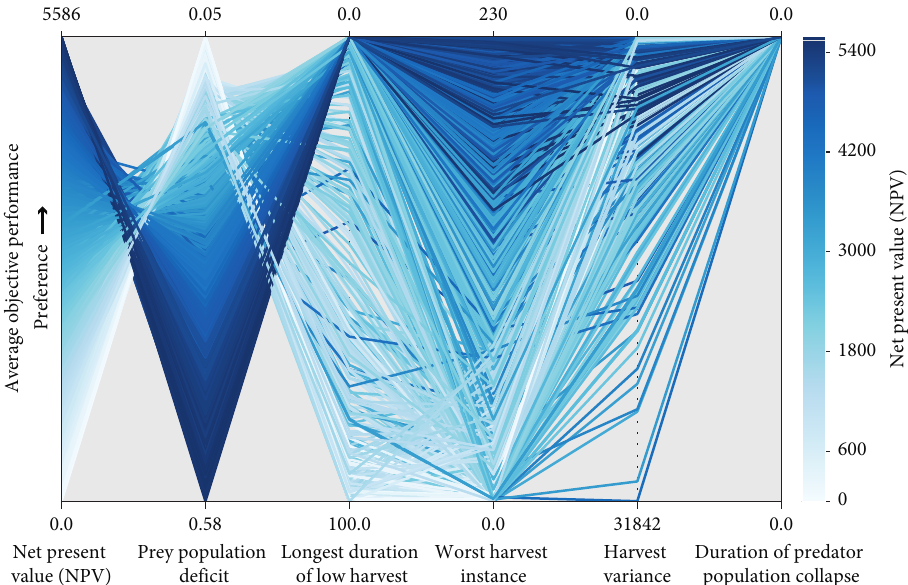
Figure 3: Parallel axis plot of the average objective values of solutions optimized in the assumed SOW. The points where each line (solution) intersects with a vertical axis represent the average performance value across 100 realizations of environmental stochasticity. The plot is oriented such that the ideal solution would be a horizontal line crossing the top of each vertical axis. Diagonal lines indicate pairwise tradeoffs between two objectives. The color gradient is based on the performance of each solution in the NPV objective, with darker colors representing a higher